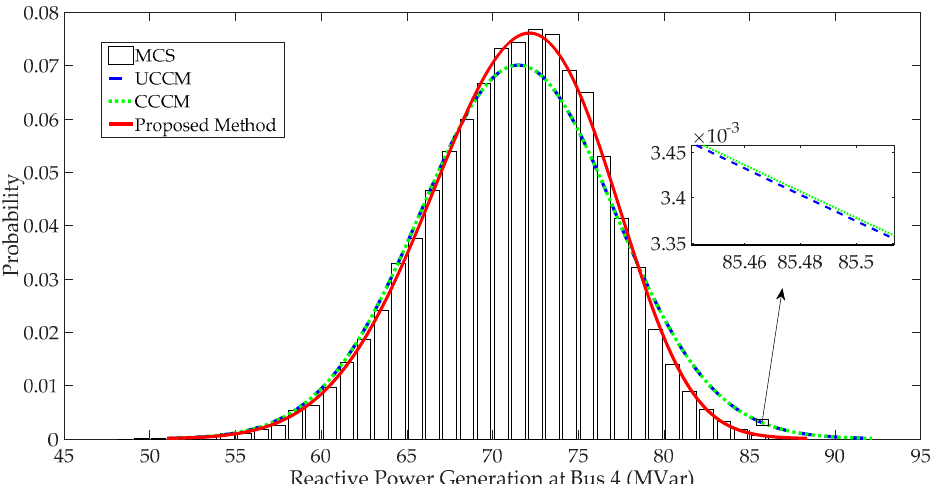
Figure 10. PDFs of reactive power generation at bus 4 (modified IEEE 118-bus test system).